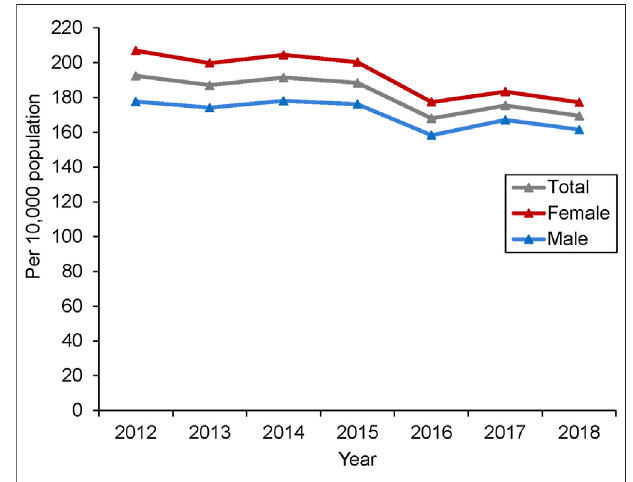
FIGURE 1 | The annual incidence of IBS during 2012 – 2018. FIGURE 2 | The annual prevalence of IBS during 2012 – 2018.